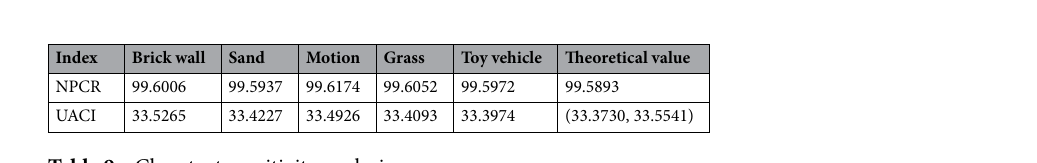
Table 9. Clear text sensitivity